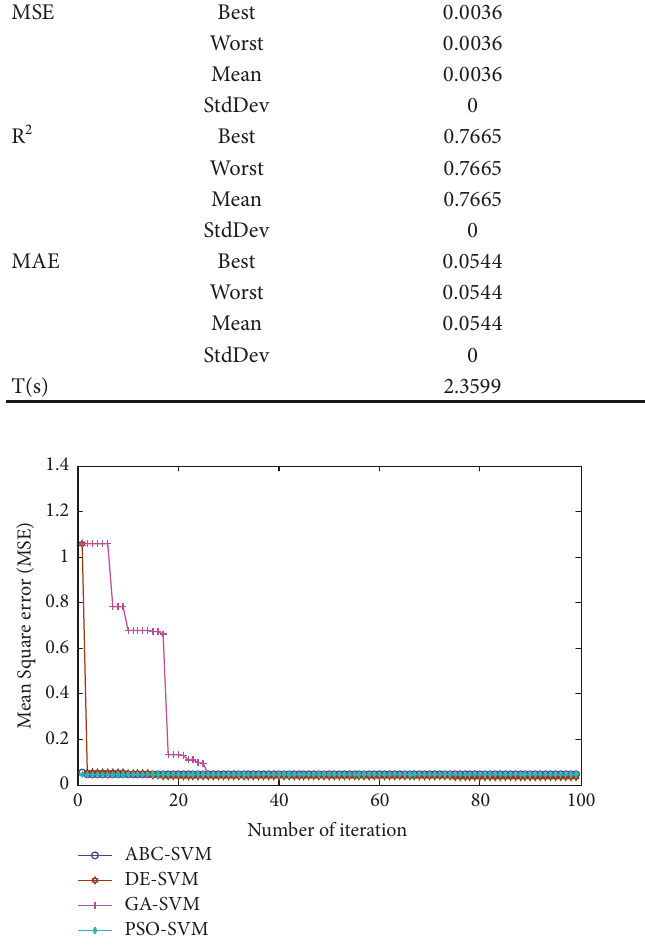
Figure 3: Marching steps for optimization of MSE for modeling Ra of AISI 1045 steel.